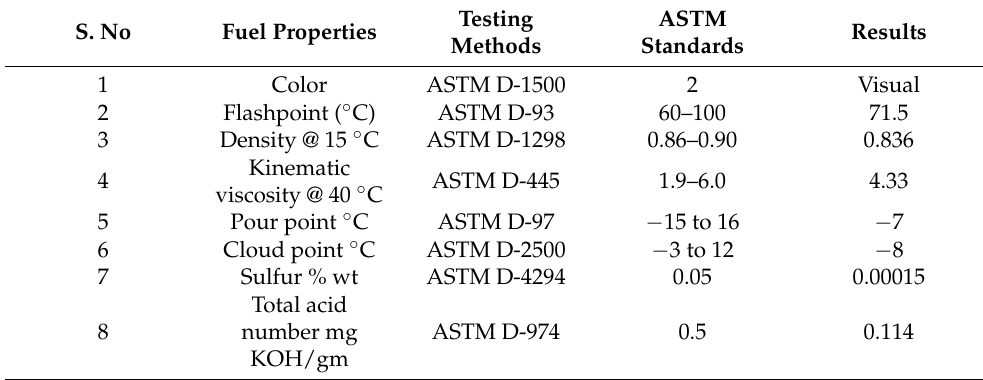
Table 6. Fuel properties of Prunus aitchisonii oil biodiesel (PAOB). S.